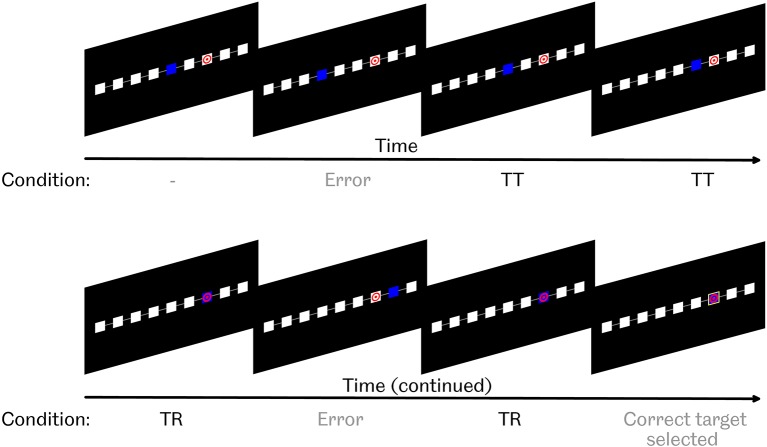
Task 1 paradigm. Participants were asked to observe as a blue cursor attempted to navigate toward, and select, a marked target square. If the cursor was on the target, possible actions were either to select it by drawing a yellow box around the square, or take 1 step away from the target. If the cursor was not on the target, possible actions were either to move 1 step toward the target, move 1 step further away from the target, or erroneously select the current square as the target by drawing a yellow box around it. “TT” condition refers to “toward target,” i.e., movements toward, but not reaching, the target. “TR” condition refers to “target reached,” i.e., movements that did reach the target.